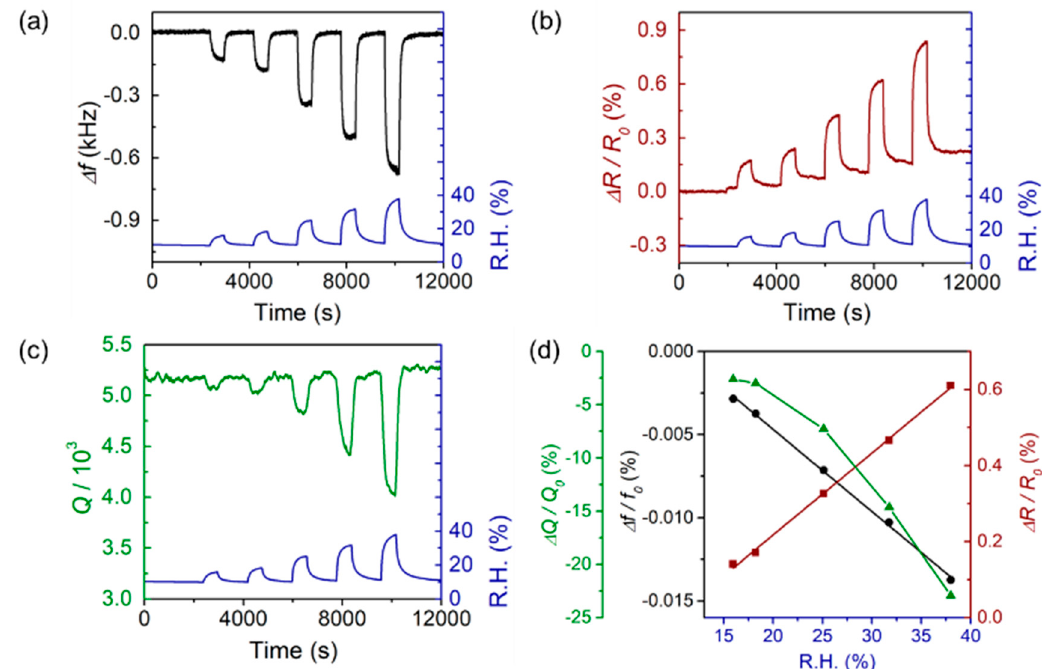
Figure 4. Simultaneously measured ( a ) resonance frequency changes (black), ( b ) electrical resistance changes (red), and ( c ) smoothed Q factor changes (green) by varying the relative humidity, which were measured by a commercial humidity sensor (blue). ( d ) the maximum relative measurement of each change for each cycle is plotted by the relative humidity. f0 = initial resonance frequency during trial; R0: Original electrical resistance = 1.58 k Ω at t = 0; and Q 0 = initial Q factor during trial.